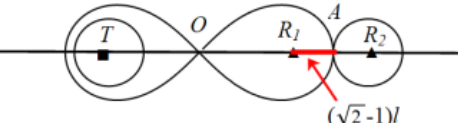
Figure A2. Maximum placement interval of T − R n when n = 2 (The length of the red segment is d 2 = ( 2 − 1 ) l , where d 2 is the second maximum deployment interval).